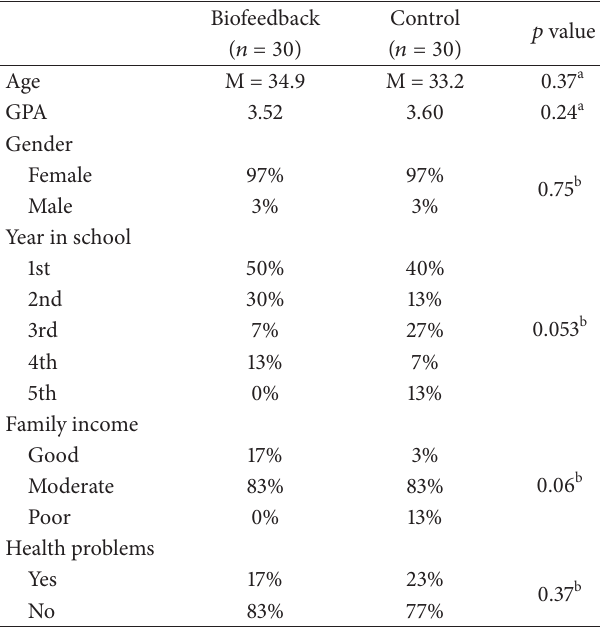
Table 1: Basic characteristics of the biofeedback group and the control group.